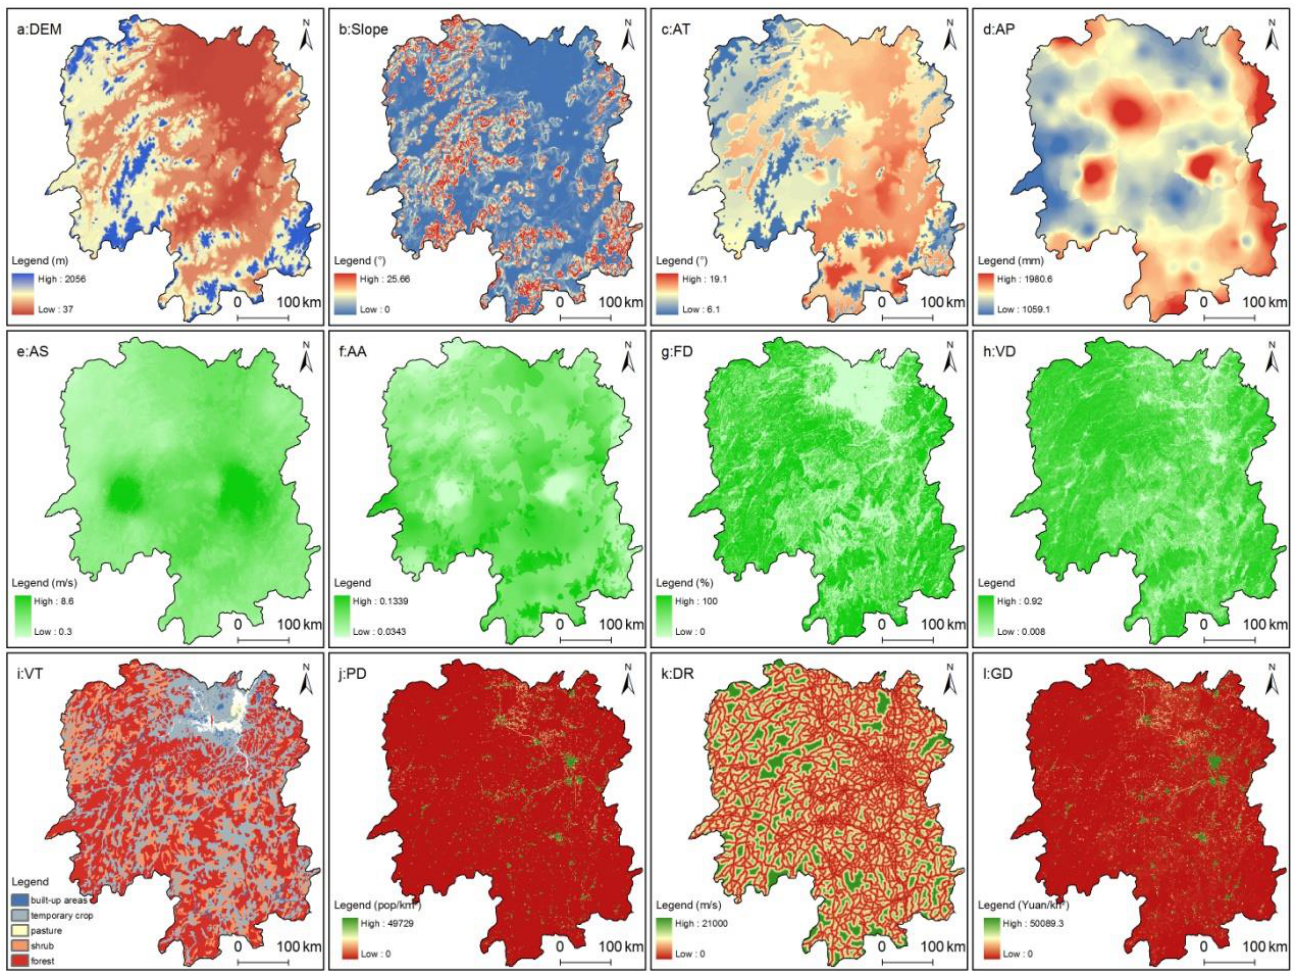
Figure 4. The factors influencing wildfire as follows: ( a ) a digital elevation model; ( b ) slope; ( c ) average temperature; ( d ) average annual precipitation; ( e ) average wind spends; ( f ) average aridity; ( g ) forest density; ( h ) vegetation cover density; ( i ) land cover type; ( j ) population density; ( k ) distance to the nearest road; ( l ) gross domestic product density.